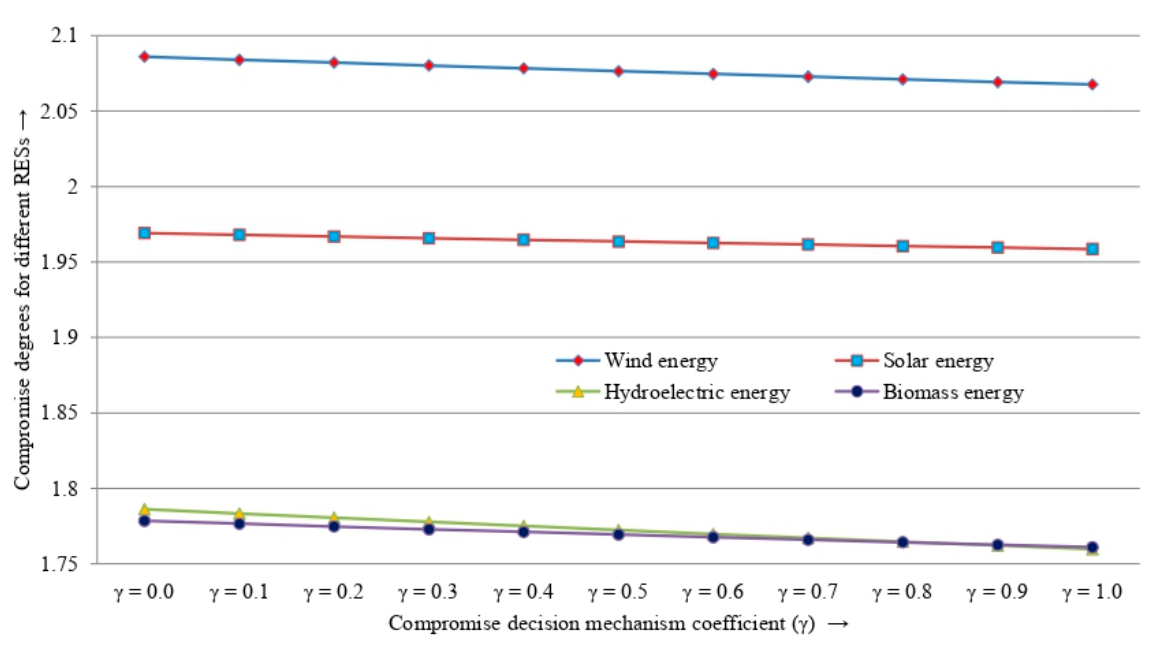
Figure 4. Compromise degrees of RESs concerning various values of γ .